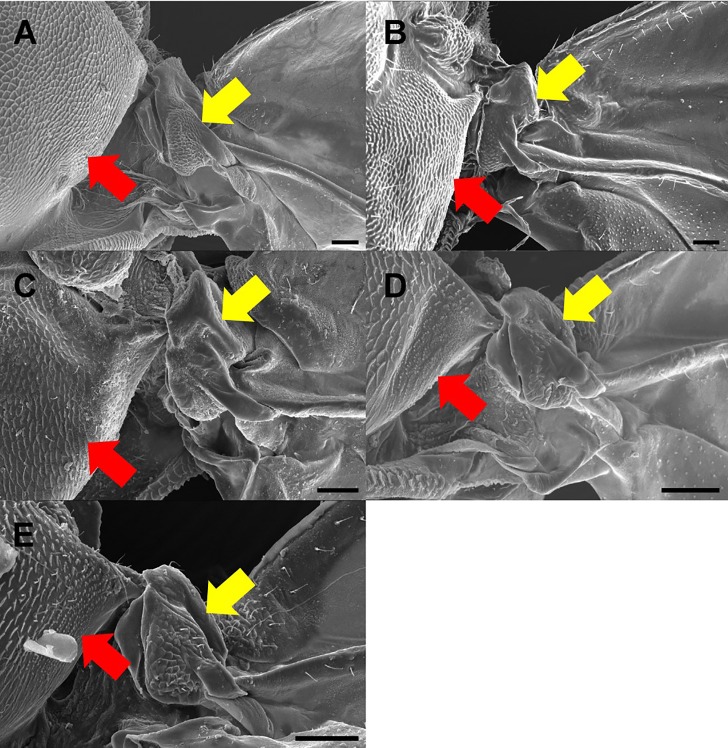
Photographs of scanning electron microscope showing dorsal view of the axillary sclerite in five species of psyllids belonging to different families.A: Macrohomotoma gladiata Kuwayama; B: Trioza sozanica (Boselli); C: Mesohomotoma camphorae Kuwayama; D: Cacopsylla oluanpiensis (Yang); E: Cacopsylla tobirae (Miyatake). Yellow arrow: Protuberances on the surface of secondary axillary sclerite. Red arrow: scale-like surface of mesothorax scutum.